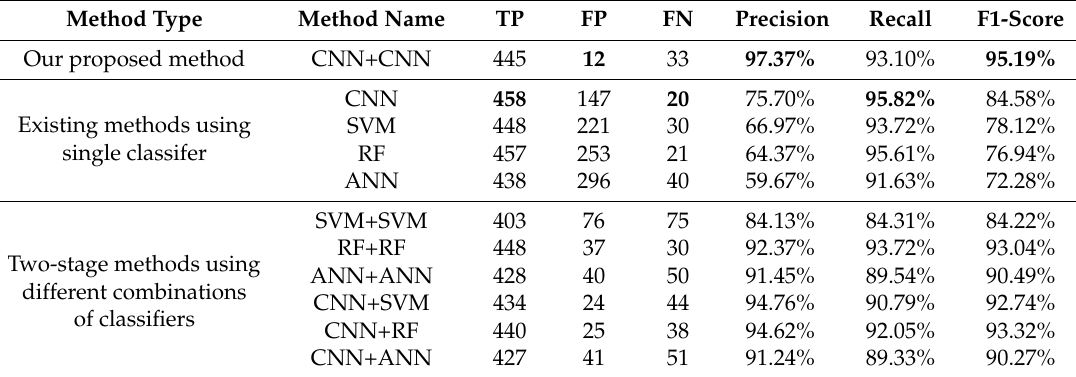
Table 3. The detection results of each method in Region 1.